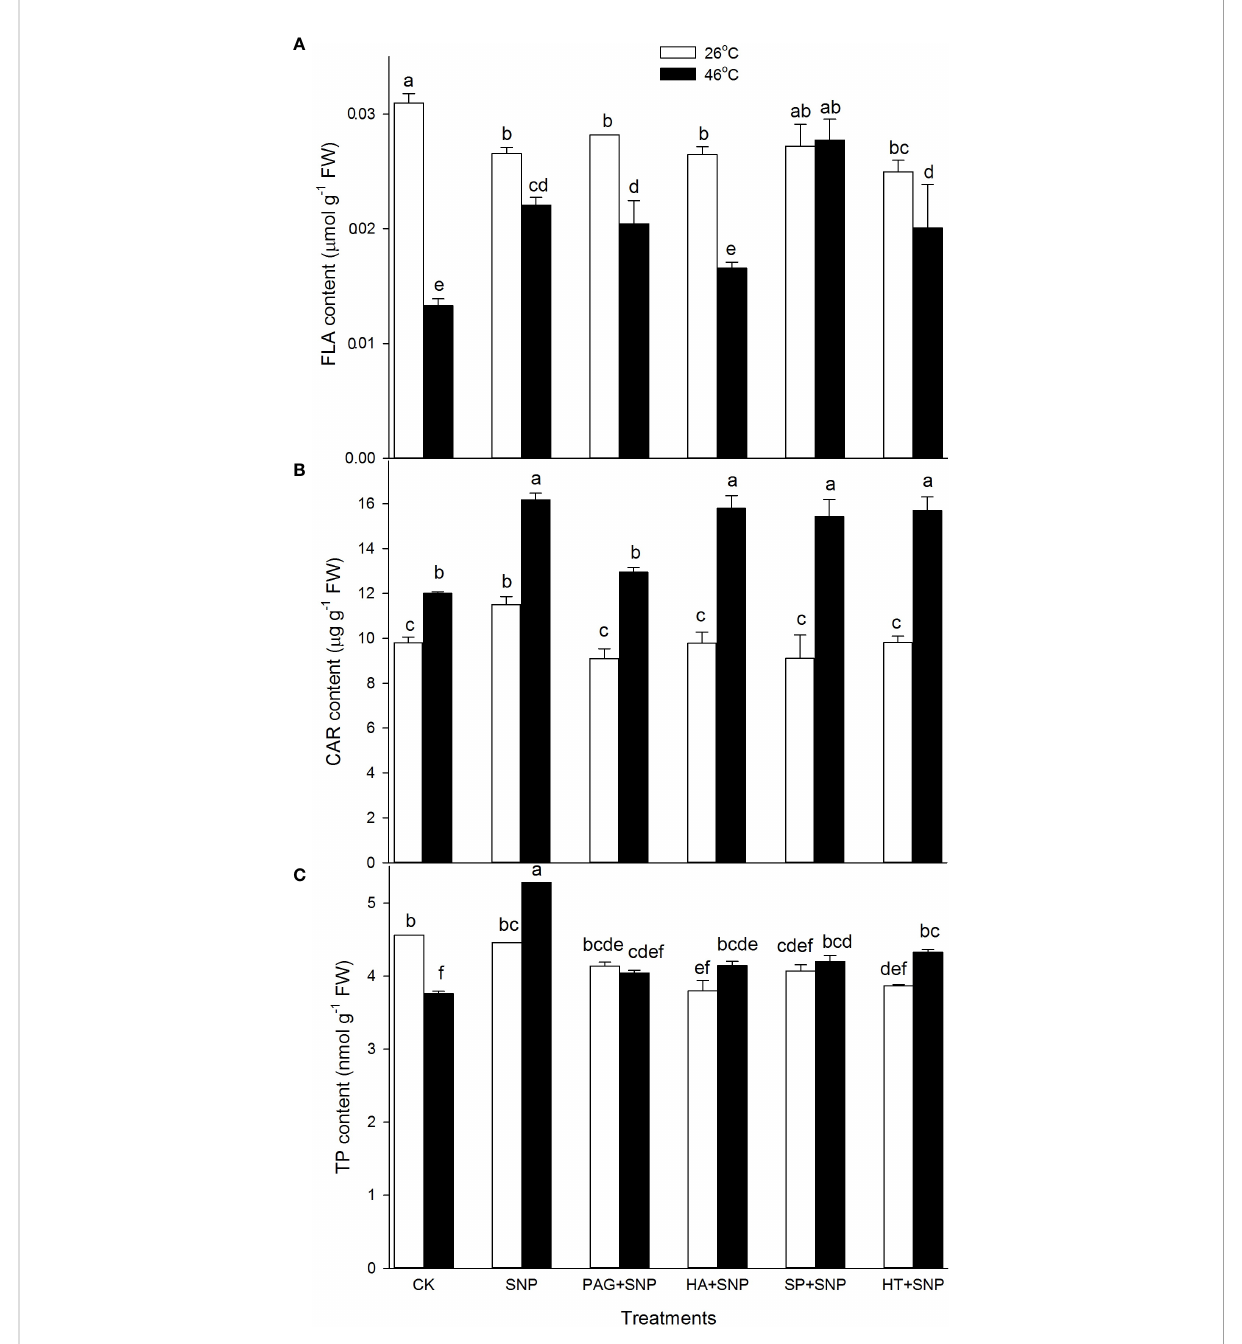
FIGURE 7 Effect of SNP alone or in combination with hydrogen sul fi de (H 2 S) inhibitors and scavengers on fl avonoids (FLA) (A) , carotenoids (CAR) (B) , and total phenols (TP) (C) contents in maize seedlings under non-HS and HS conditions. The data had at least three biological replicates and were tested using Duncan's multiple-range test at 0.05 signi fi cant level, which denote means ± standard error (SE). The bars with the different letters represent signi fi cant differences, while the same letters represent no signi fi cant